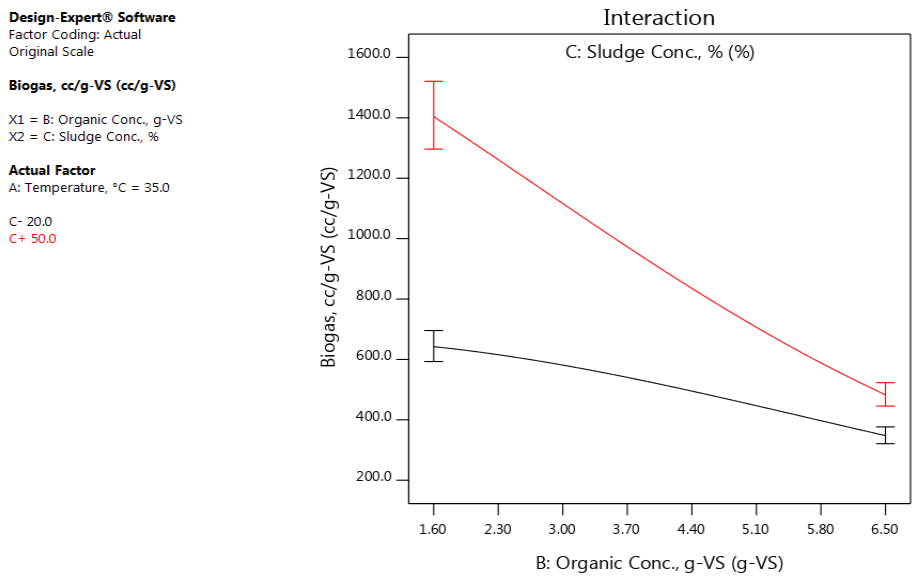
Figure 5. An interaction plot shows the influence of the BC interaction on the biogas volume/g-VS/0.2 L.